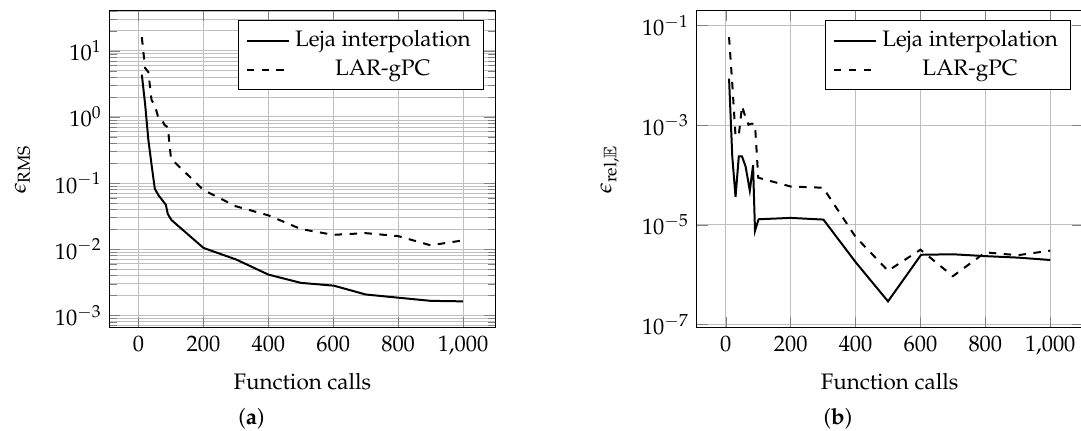
Figure 2. Cost-error relation for the approximations of the borehole model. The approximations are constructed with a dimension-adaptive weighted Leja interpolation algorithm [37] and with a degree-adaptive LAR-gPC (least angle regression-generalized polynomial chaos) algorithm [9,50]. The size of the validation sample is Q = 10 5 . The reference expected value is computed with quasi-MC (Monte Carlo) integration based on a Sobol sample size equal to 10 8 : ( a ) RMS (root-mean-square) validation error, ( b ) Expected value relative